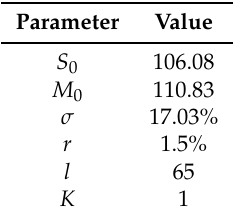
Table 2. Input parameters for pricing π -put option on the Microsoft Corporation